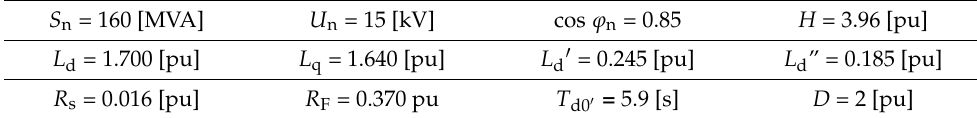
Table A6. Manufacturer’s data: turbo-type synchronous generator S n = 160 MVA.